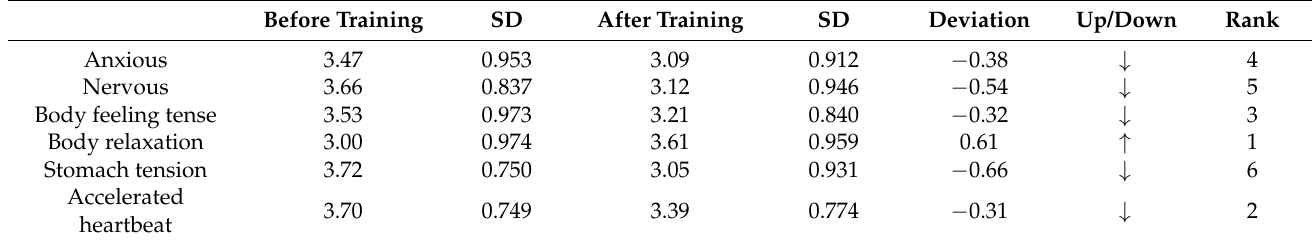
Table 5. Perception analysis of the effect of imagery training on physical anxiety.